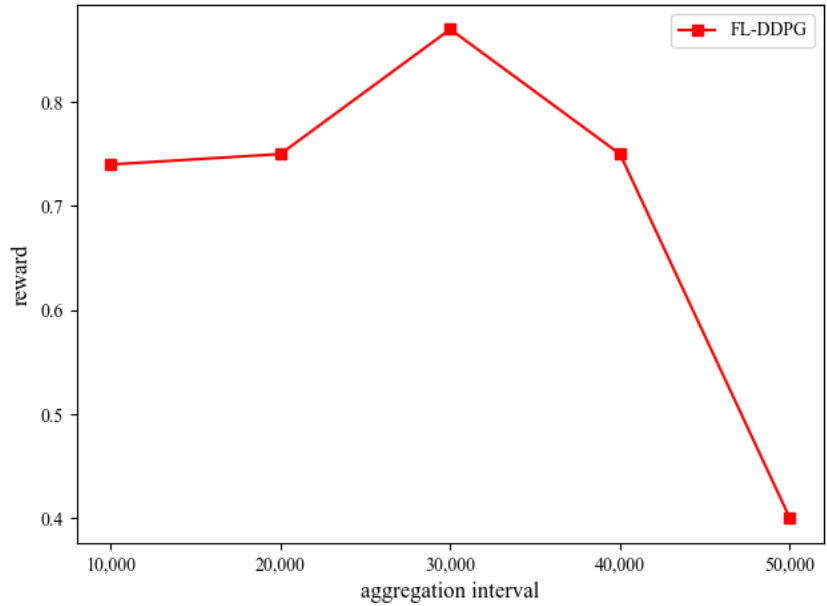
Figure 4. Performance evaluation on aggregation